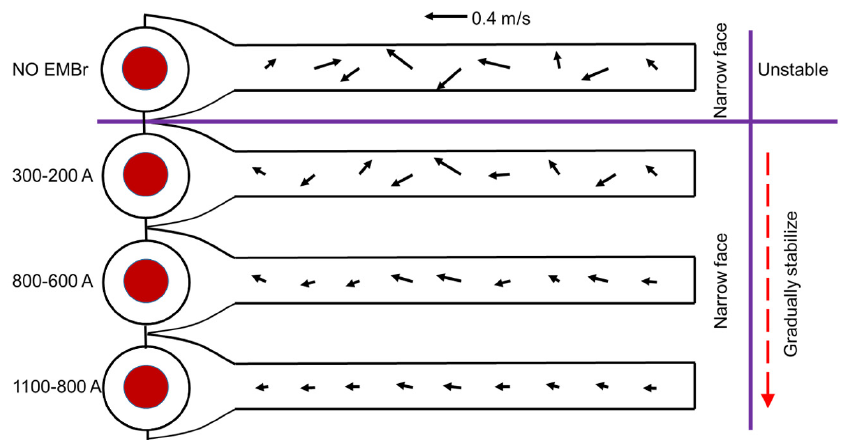
Figure 20. Vector diagram of surface velocity on the meniscus.